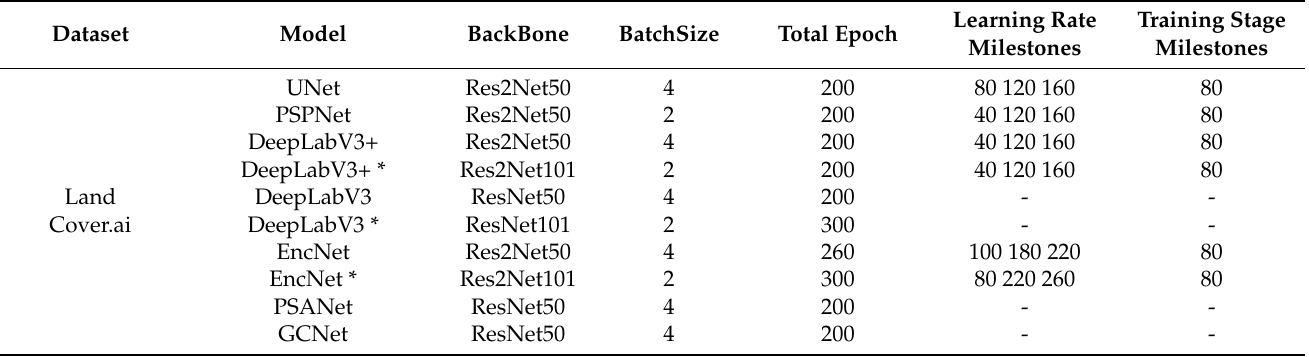
Table 8. Training hyperparameters for each state-of-the-art model on the three datasets. (* represents using a 101-layer resnet.). Dataset